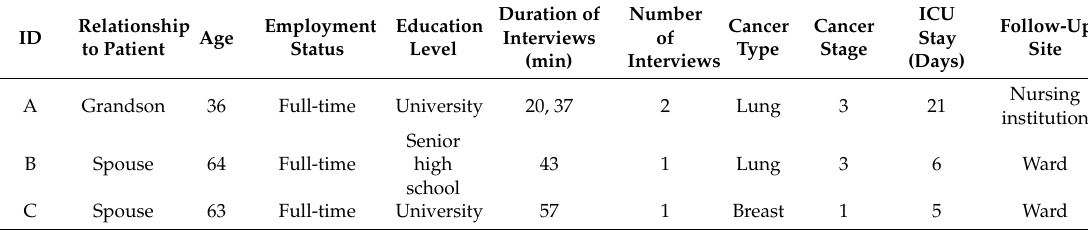
Table 1. Characteristics of surrogates and patients (n =